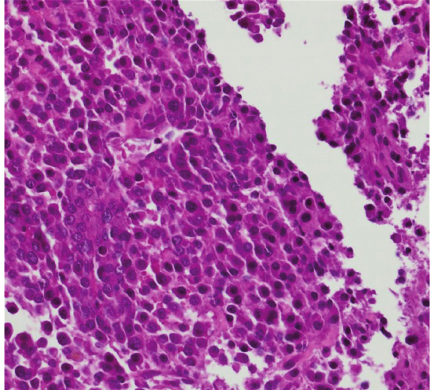
Figure 2: Core biopsy of the abdominal mass demonstrating sheets of atypical plasma cells which were positive with monoclonal kappa light chain staining by immunoperoxidases stains. No staining was seen for lambda light chains. (H&E stain, 20x magnification).